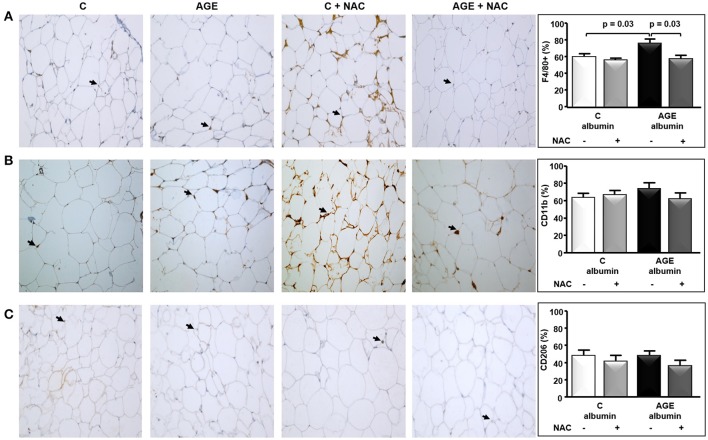
Immunostaining for F4/80, CD11b, and CD206 in periepididymal adipose tissue. Periepididymal adipose tissue sections from animals treated with C-albumin (n = 8), C-albumin + NAC (n = 7), AGE-albumin (n = 8) and AGE-albumin + NAC (n = 7) were evaluated by immunohistochemistry. (A) Representative images of histological sections; black arrows indicate positive cells (macrophage) stained with antibody against F4/80 (Abcam 1:100); 400 X magnification. (B) Representative images of histological sections; black arrows indicate positive cells stained with antibody against CD11b, marker of M1-macrophage (Abcam 1:200); 400 X magnification. (C) Representative images of histological sections; black arrows indicate positive cells stained with antibody against CD206, marker of M2-macrophage (Abcam 1:1250) (400 X magnification). Representative graphics were obtained after stereological analysis. Results (mean ± SEM) were compared by One-way ANOVA with Newman-Keuls post-test.